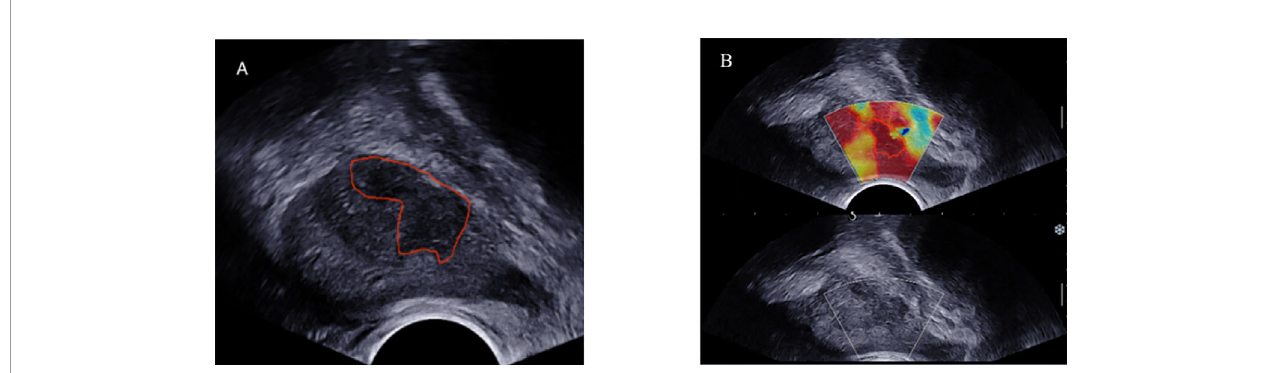
FIGURE 3 | TRUS B-mode ultrasound imaging (A) and SWE imaging (B) from the same position of 74-year-old PCa patient (fPSA, 1.28 ng/ml; tPSA, 7.855 ng/ml; biopsy GS,4 + 3 = 7). ROI (red solid line) was outlined in the B-mode ultrasound